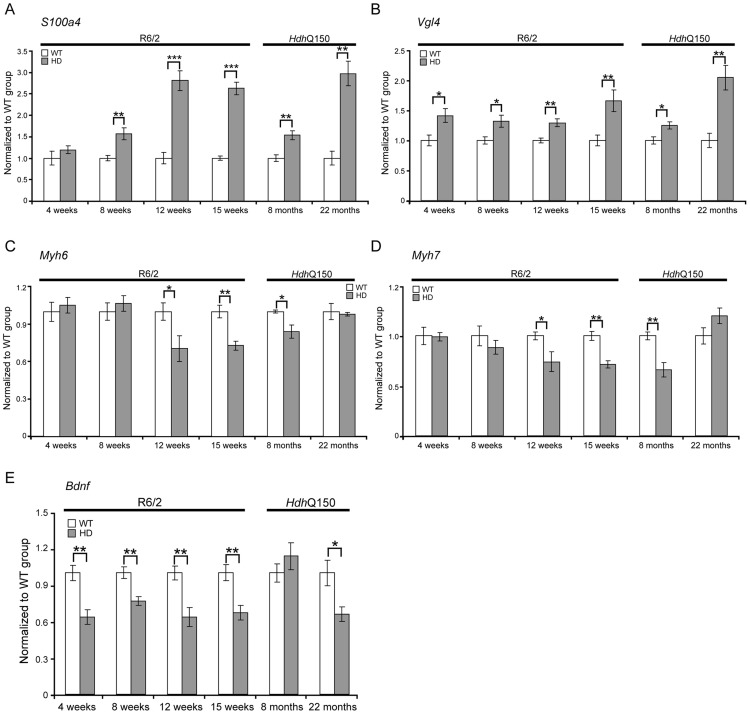
Transcriptional deregulation of gene markers involved in pathological processes.(A) S100A4 (S100 calcium binding protein A4), (B) Vgl-4 (vestigial related factor 4) transcripts were up-regulated while (C) Myh6 (myosin heavy light chain 6) (D) Myh7 (myosin heavy light chain 7) and (E) Bdnf (brain derived neurotophic factor) mRNAs were significantly decreased in the heart of R6/2 and HdhQ150 mice. All Taqman qPCR values were normalized to the geometric mean of three housekeeping genes: Actb, Cyc1 and Gapdh. Error bars are SEM (n = 6). Student's t-test: *p<0.05, **p<0.01; ***p<0.001.